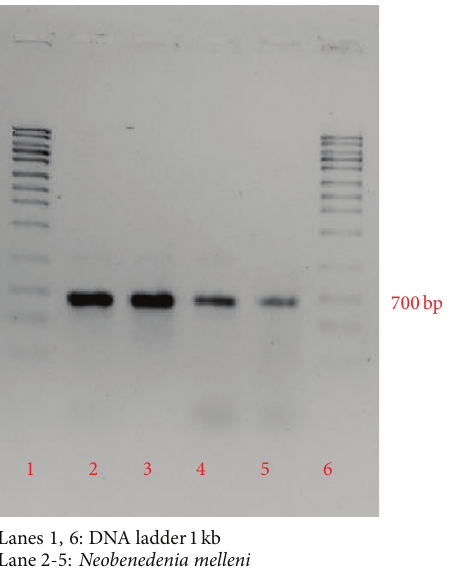
Figure 7: Gel electrophoresis of PCR 18s ribosomal RNA gene.